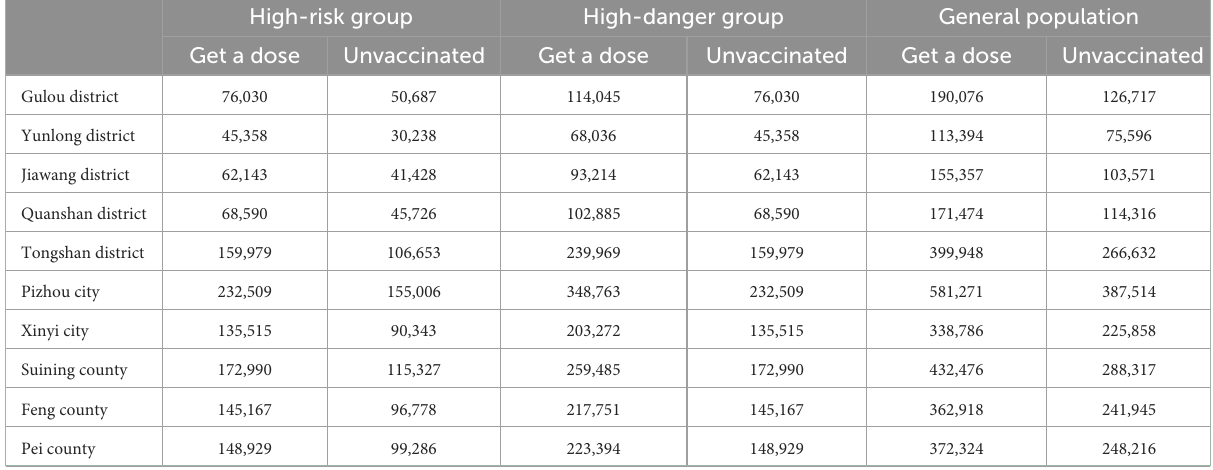
TABLE 4 Vaccination in each region.